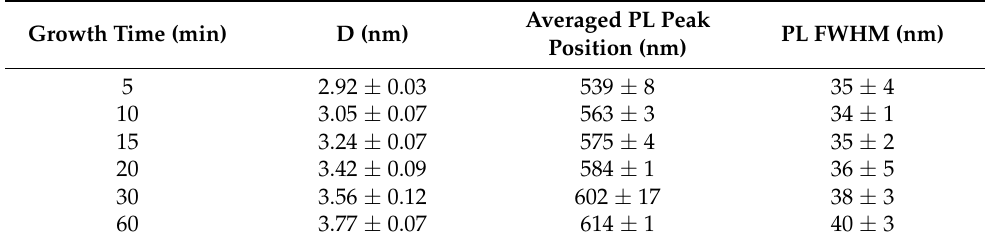
Table 3. Deconvolution derived parameters of size (d), PL peak position and full width at half maximum (PL FWHM).